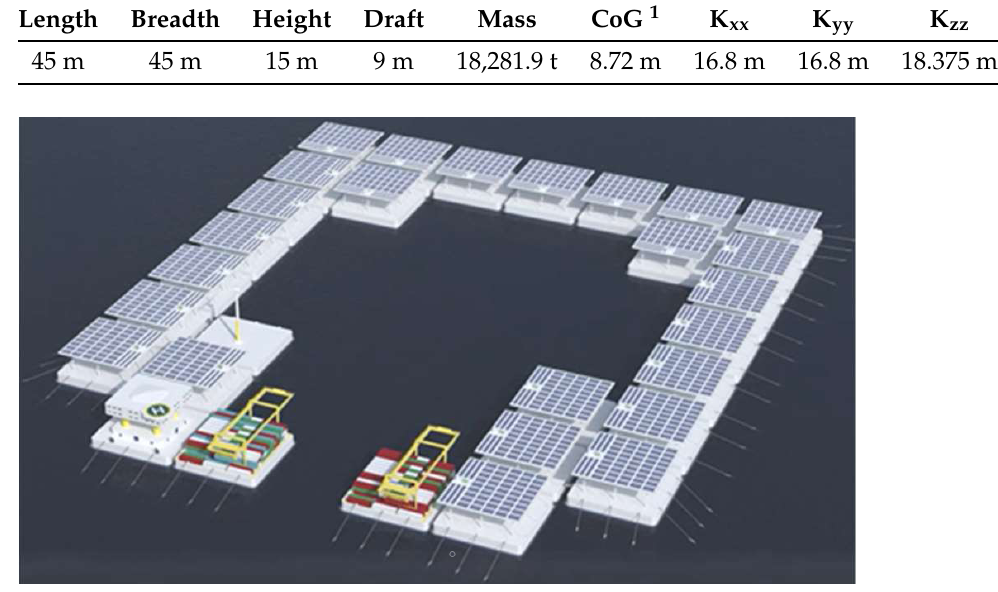
Figure 1. Layout of the multi-use floating island of Energyhub@Sea concept adopted from [29]. Reproduced with permission from Maarten Flikkema, Floating Island Development and Deployment Roadmap; published by Space@Sea project, 2021.